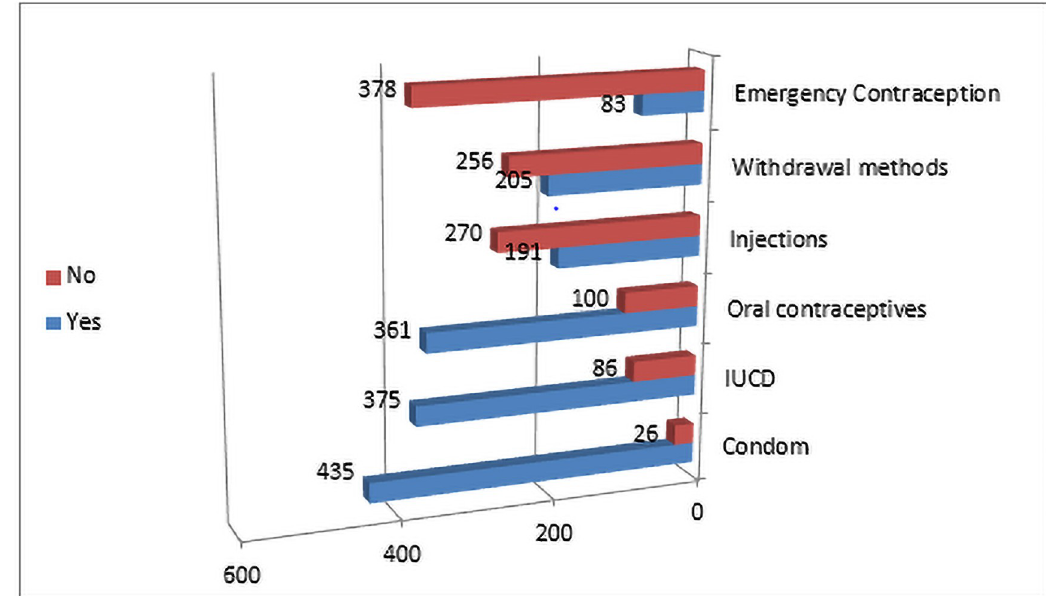
Fig 1. Men’s knowledge about different methods of